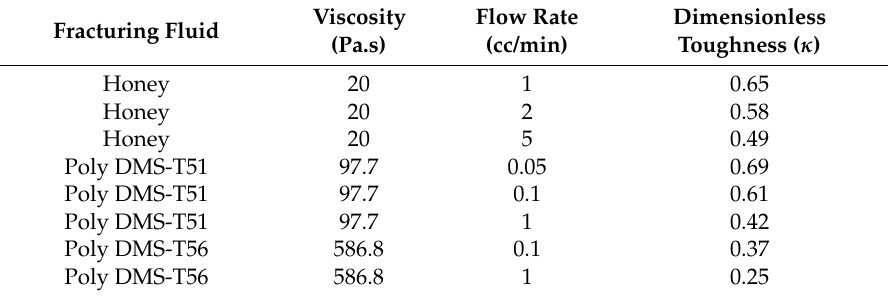
Table 3. Dimensionless toughness number for each fracturing fluid flowing at a particular flow